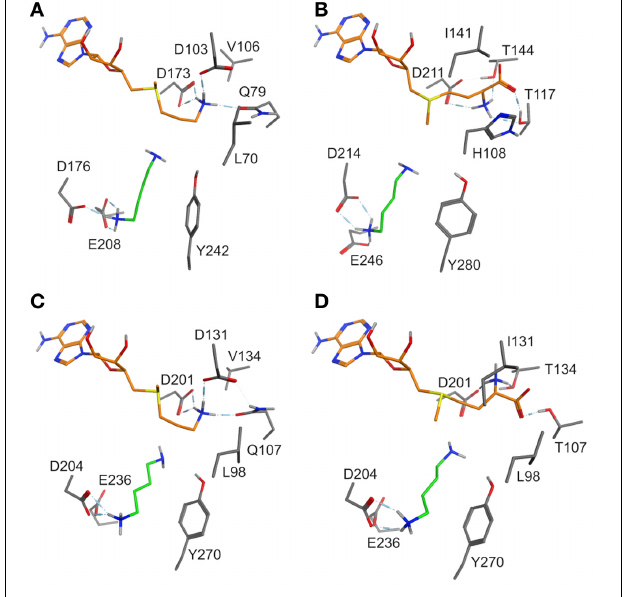
FIGURE 2 | (A) Binding mode of putrescine (green carbon atoms) and of the methionine moiety (orange carbon atoms) of dcSAM in DsSPDS1 wild type, (B) SAM in DsPMT, (C) dcSAM in AtSPDS1 wild type, and (D) SAM in AtSPDS1 mutant with exchanges D131I, Q107T, V134T. For clarity, all non-polar hydrogen atoms are not displayed.